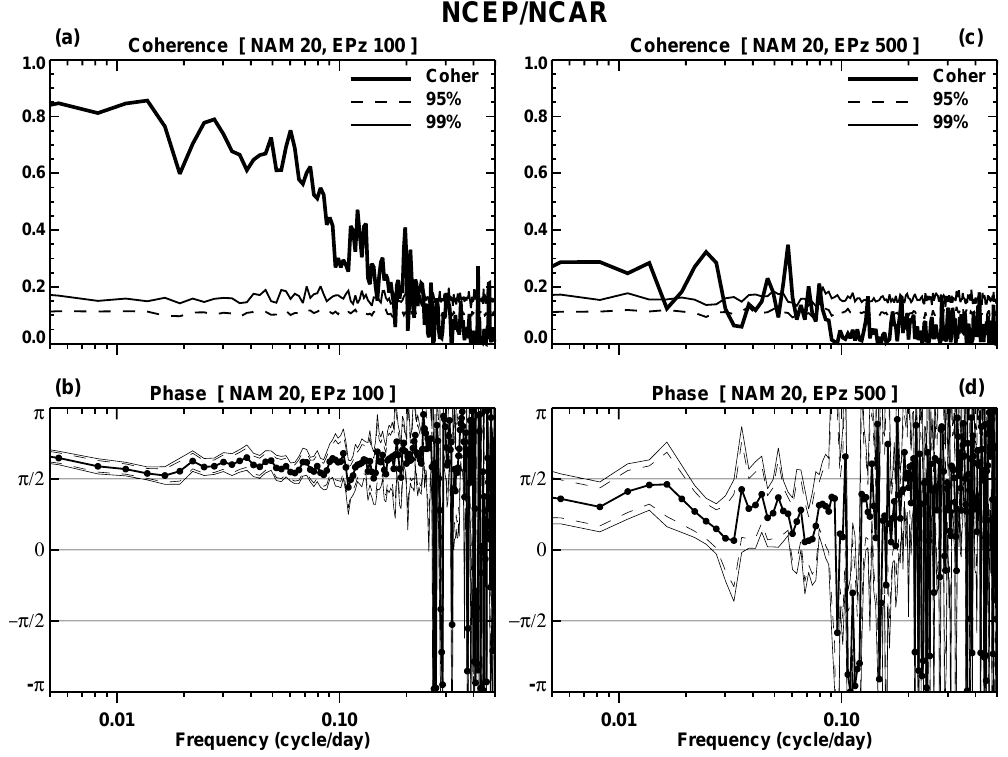
Fig. 3. Cross-spectral analysis between the NAM index at 20hPa and the vertical EP flux anomalies averaged over 45 ◦ –75 ◦ N at (a, b) 100hPa, (c, d) 500hPa. Dashed and thin solid lines are the 95% and 99% confidence levels respectively. The NCEP-NCAR